Question: Author a descriptive caption for the visualization shown.
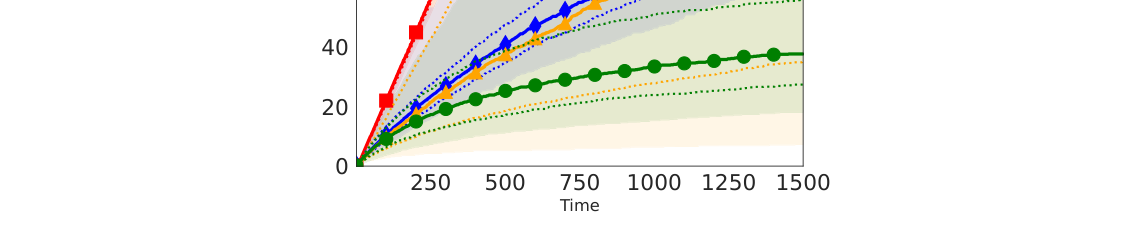
Answer: 1 – Left: two-armed Gaussian expectile bandit. Center: two-armed linear expectile bandit with R3 contexts and expectile-based asymmetric noises. Right: two-armed Bernoulli entropic risk bandit. Thick lines denote median cumulative pseudo regret over 500 independent replicates. Dotted lines denote the 25 and 75 pseudo regret percentiles. Shaded areas denote the 5 and 95 percentiles.